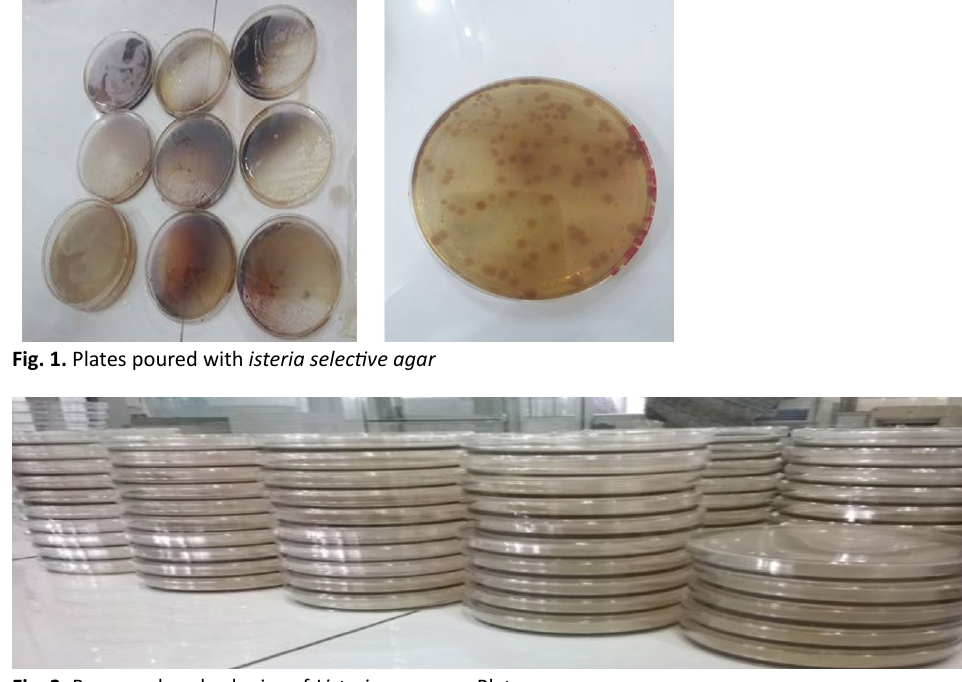
Fig. 2. Brown colored colonies of Listeria grown on